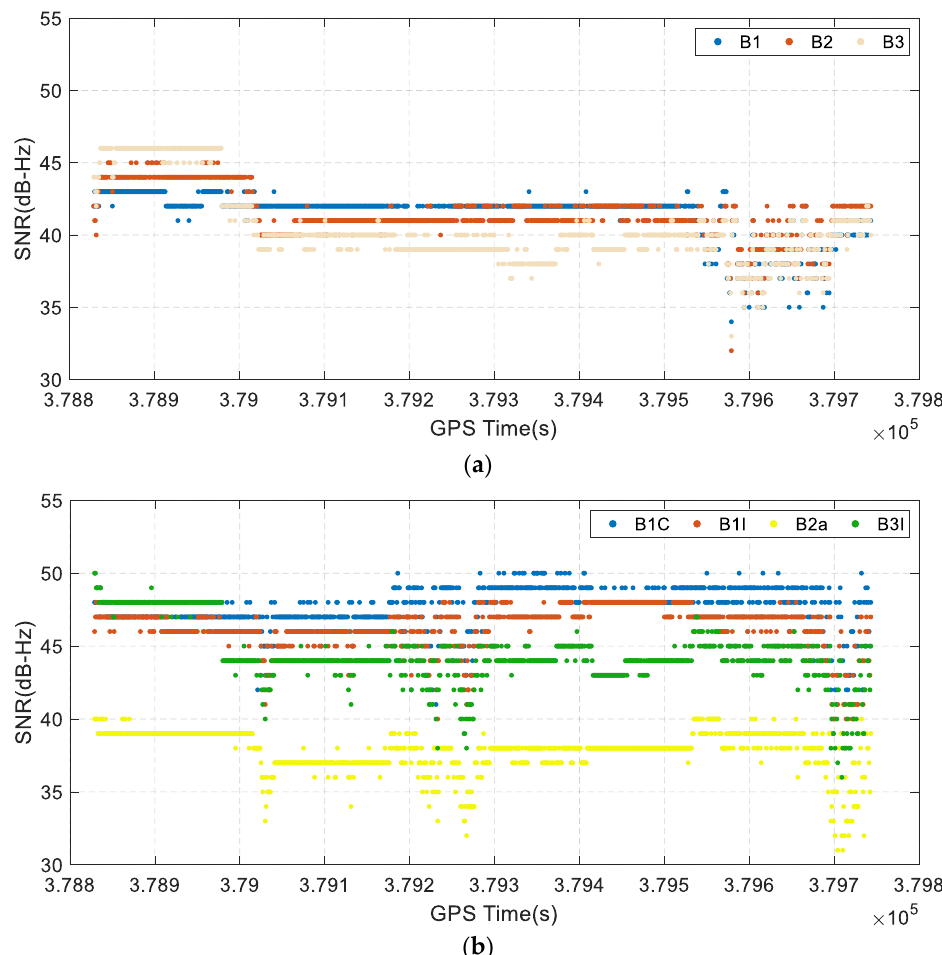
Figure 6. The signal-to-noise ratio of triple-frequency and four-frequency observations in the exper- iment: ( a ) BDS-2 C07; ( b ) BDS-3 C36. ment: ( a ) BDS-2 C07; ( b ) BDS-3